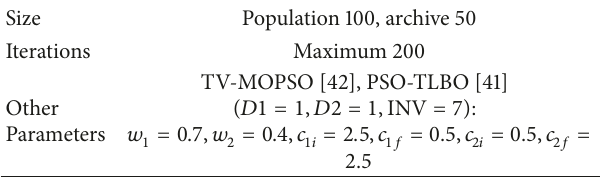
Table 1: Algorithm parameters.